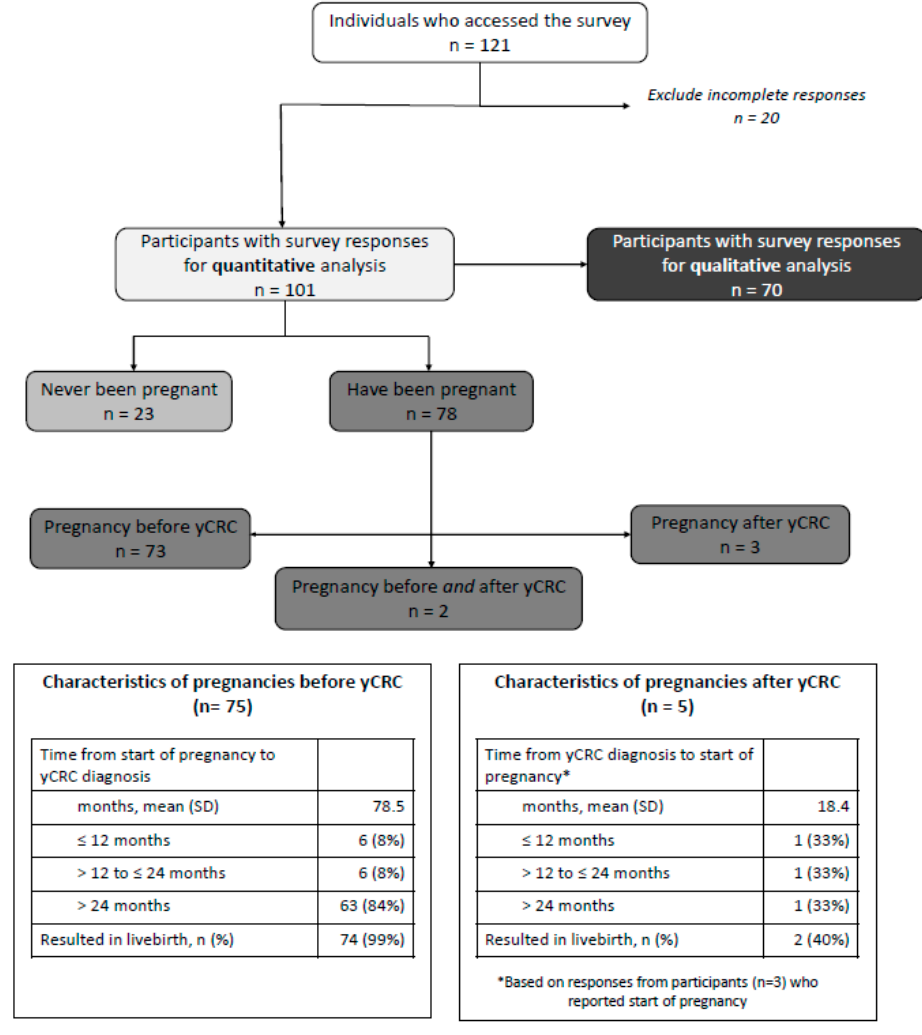
Figure 1. Participant flow and characteristics according to pregnancy history. With respect to the impacts of yCRC on reproductive decisions, one-third of partici- pants (34, 33.7%) indicated that their yCRC diagnosis influenced their family planning goals, including nine (39.1%) of those who had never been pregnant and 25 (32.1%) of those who had been pregnant. As shown in Table 3 , age at yCRC diagnosis was a predic- tor, particularly among participants diagnosed at between 20 and 29 years (adjusted odds ratio (aOR), 22.73; 95% confidence interval (CI), 3.53 to 146.39) and 30 to 39 years (aOR, 21.94; 95% CI, 5.59 to 86.18) as compared to those diagnosed at between 40 and 49 years. Participants currently undergoing treatment were more likely to indicate that their yCRC